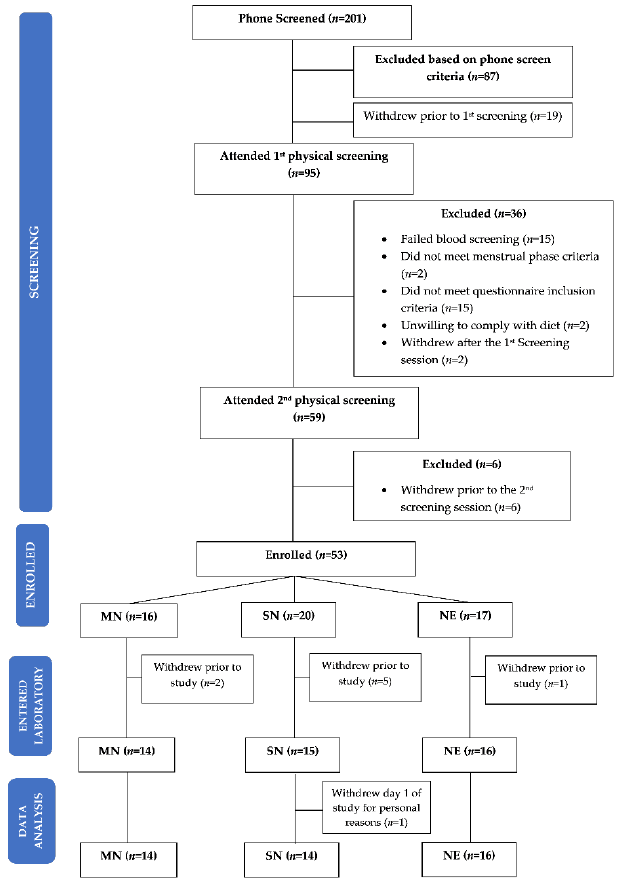
Figure 3. Consort diagram of participants who were screened, enrolled, entered the laboratory, and completed data analysis. MN = Meal at Night condition; SN = Snack at Night condition; NE = No Eating at Night condition.